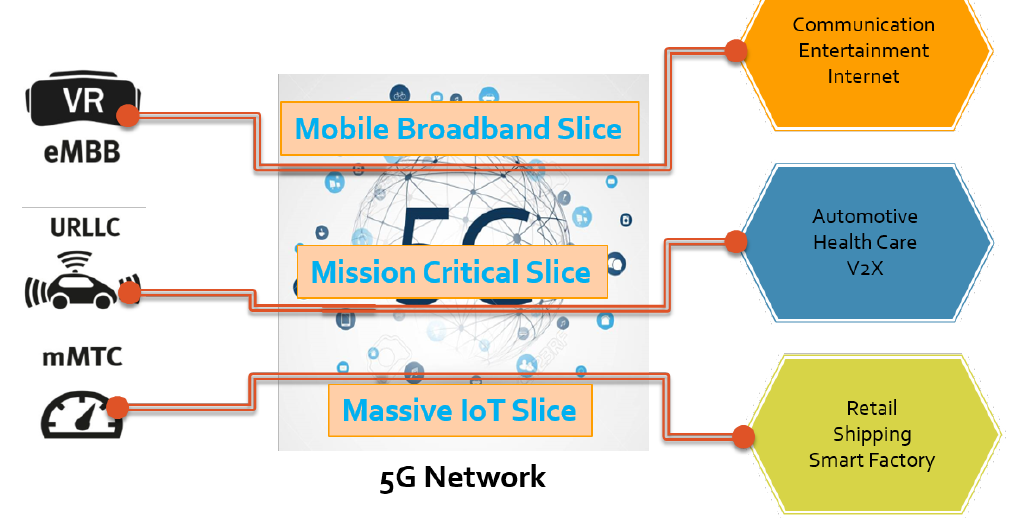
Figure 1. Types of slices in 5G